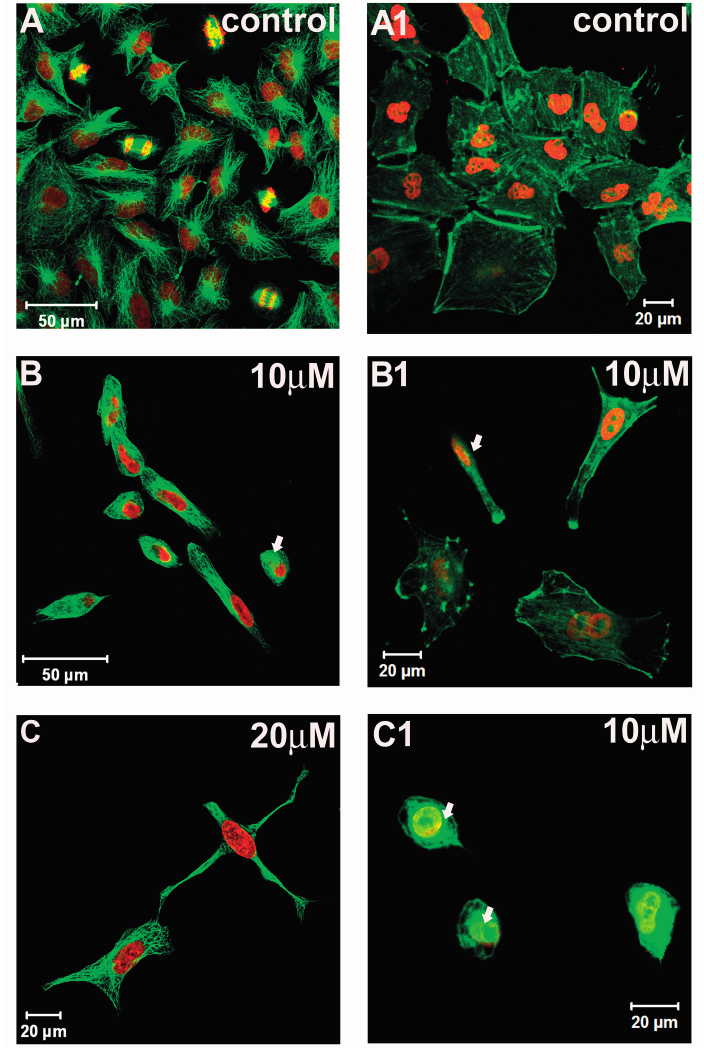
Figure 4. Images obtained by laser-scanning confocal microscopy evidencing microtubule network ( A – C ) and microfilament distribution pattern ( A1 – C1 ) in A549 cells in